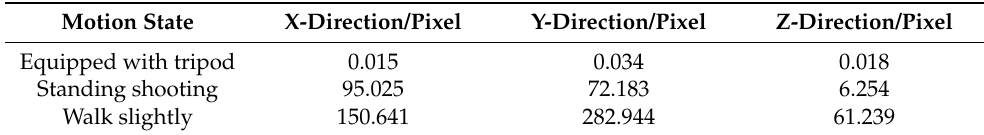
Figure 11. Displacement time histories comparison in three directions of three shooting states using a smartphone. Table 2. Displacement peak value under different conditions when using a smartphone.